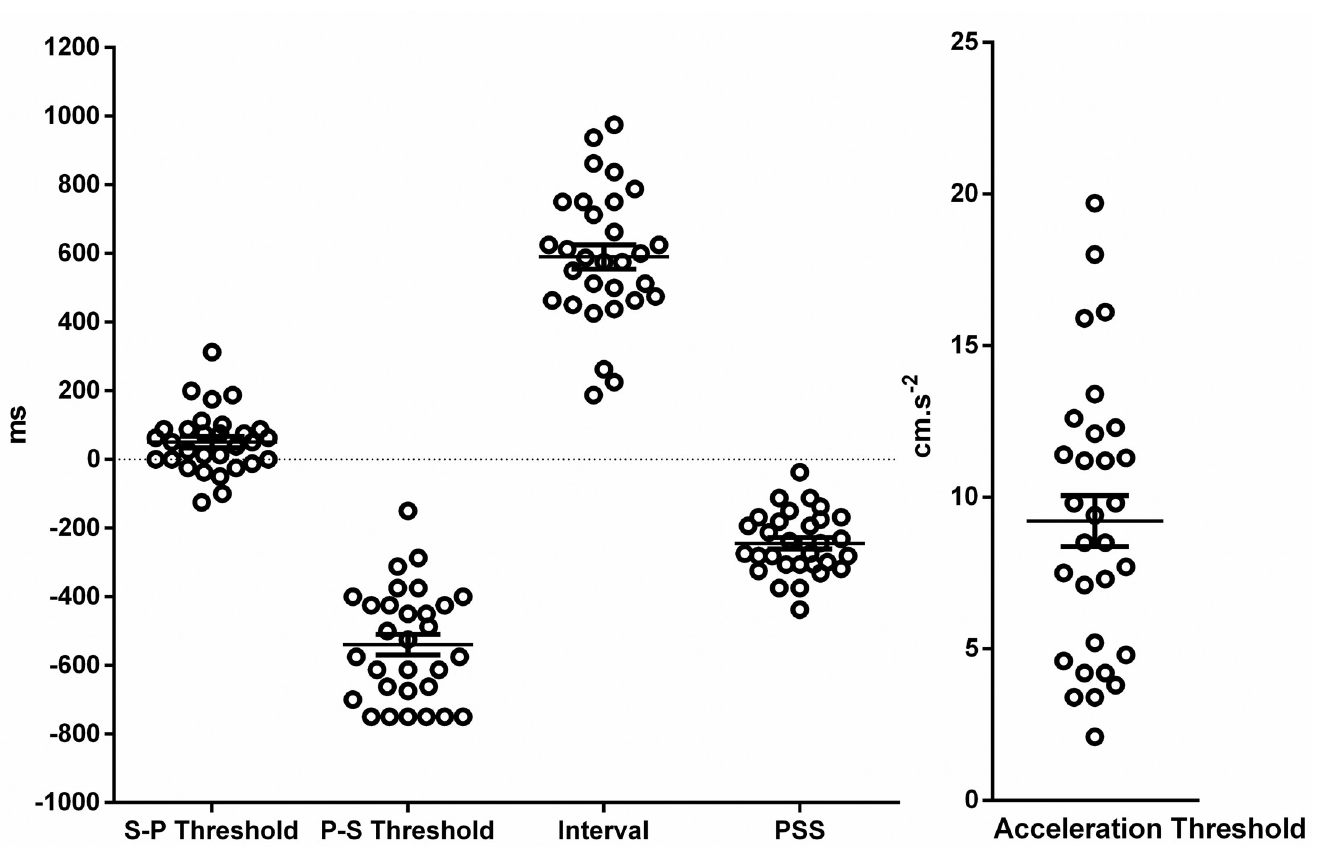
Fig 3. Dispersion of sound-peak (SP) and peak-sound (PS) thresholds, synchronous perception intervals, point of subjective synchronicity (PSS) and acceleration thresholds. Open circles represent individual values (n = 30). Each value is the mean of 2 or 4 replicates. Horizontal bars represent mean and the error bars depict standard deviation. For the delays, the zero was defined by the peak of the bed oscillation (head at its maximal height). The point of subjective synchronicity which represents the middle of the synchronous perception interval had a negative value in all cases.